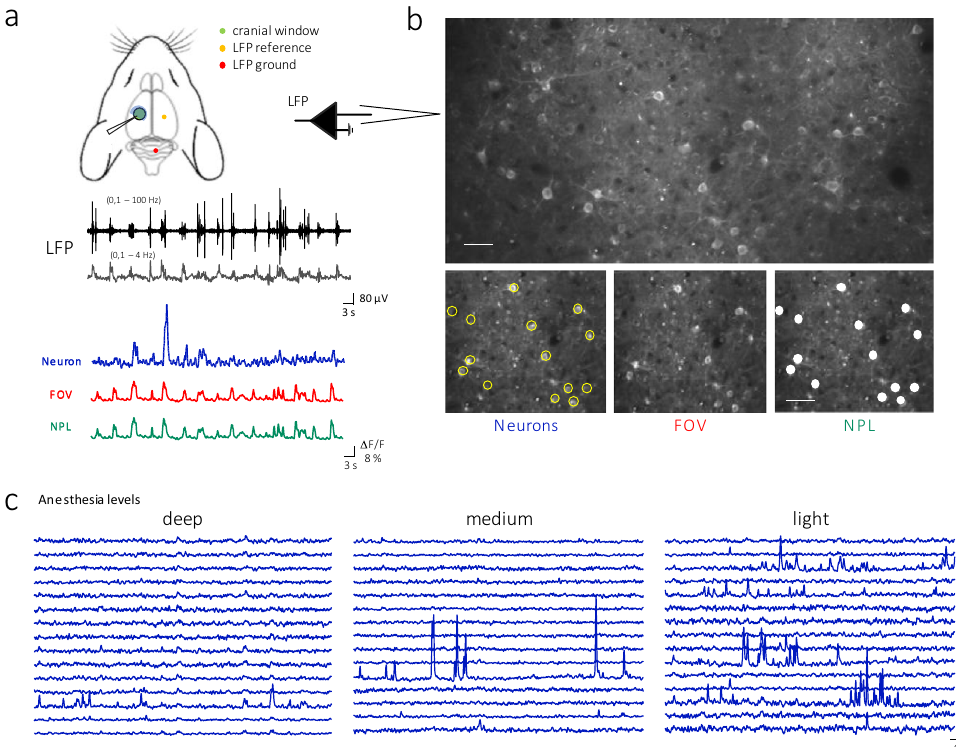
Figure 1. Simultaneous electrophysiological and two-photon imaging recording of L2/3 excitatory neurons activity in GCaMP6f mice. a. Top. Experimental scheme. Bottom. Representative traces showing the same temporal segment for LFP (black, delta band in grey), Neurons (blue), FOV (red), and NPL (green). b. Top. Representative image of two-photon recording of L2/3 excitatory neurons in somatosensory cortex. Scale bar = 30 µm. Bottom. Representative ROIs used to extract the calcium dynamics signal from the Neurons (yellow circles), the entire Field Of View (FOV), and the Neuropil (NPL, FOV - Neurons). Scale bar = 45 µm. c. Representative time series extracted from 15 neurons in different levels of anesthesia (in this example, corresponding to decreasing percentages of isoflurane